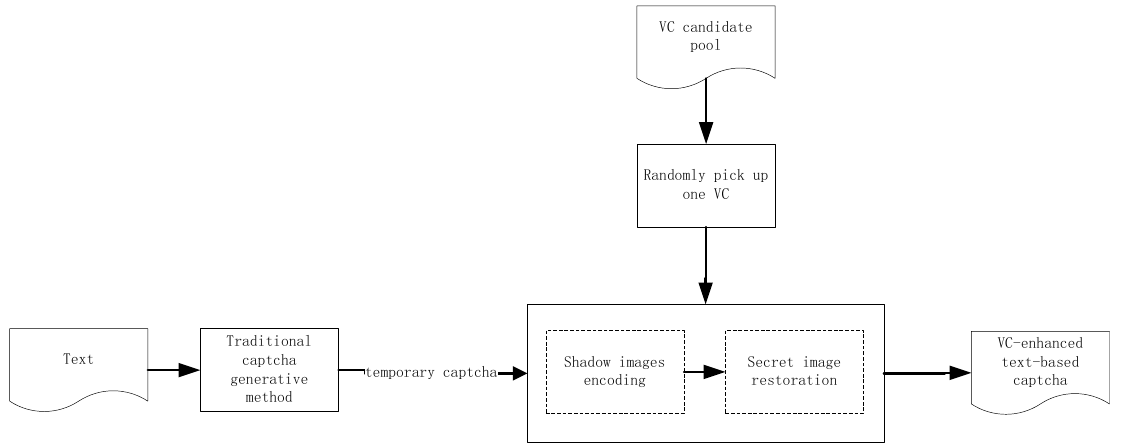
Figure 4. The design concept of our VC-enhanced text-based